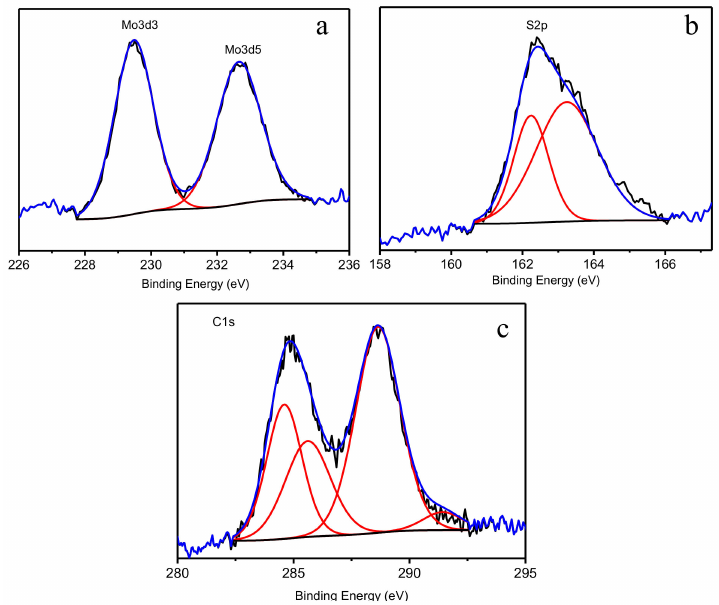
Figure 5. XPS spectra for MoS 2 -G (MS-2): ( a ) Mo, ( b ) S, and ( c )